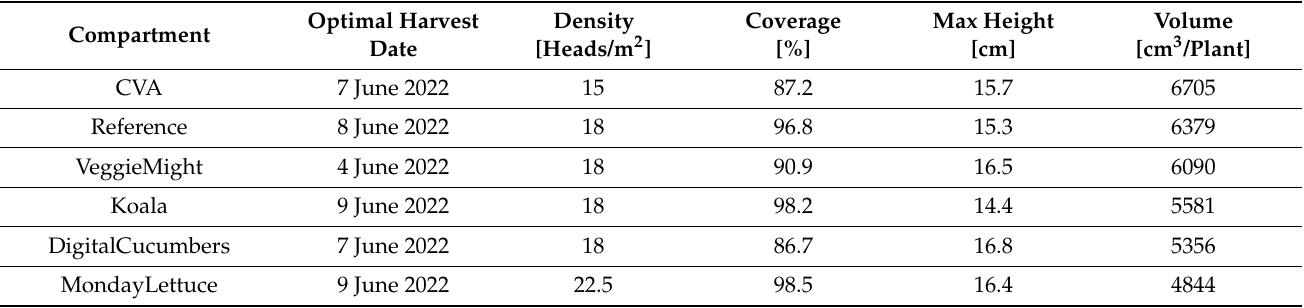
Table 3. Overview of plant traits at optimal harvest date (when target weight of 250 g per lettuce head is reached). Teams are sorted from high to low volume.